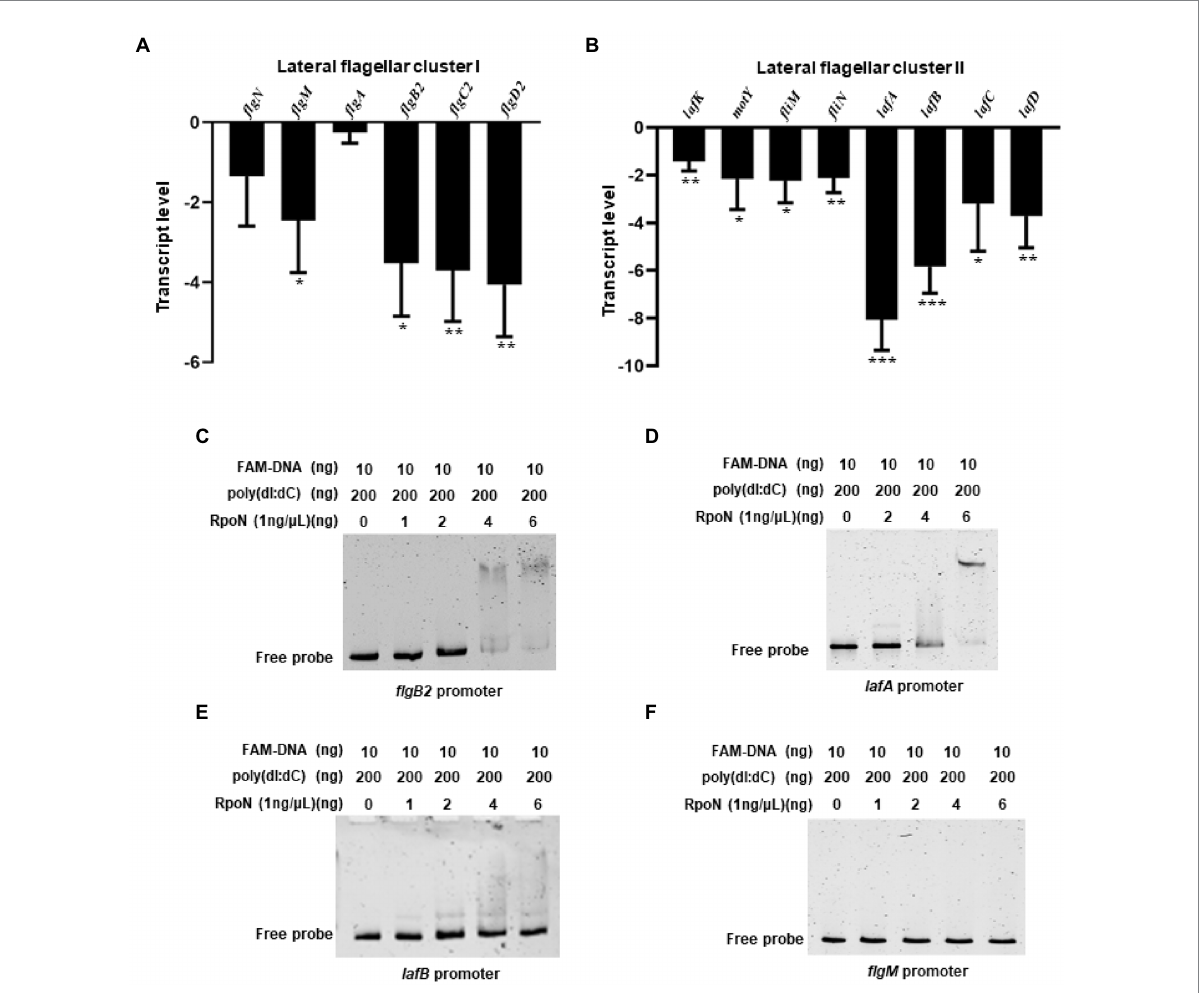
FIGURE 4 RpoN directly binds to the promoters of flgB2 and lafA to regulate the expression of lateral flagellar genes in V. parahaemolyticus . (A,B) qRT-PCR analysis of the transcription levels of lateral flagellar cluster I (A) and lateral flagellar cluster II (B) genes in Δ rpoN compared to WT. The data are presented as the mean ± SD ( n = 3). * p < 0.05, ** p < 0.01, *** p < 0.001, Student’s t test analyzes Δ rpoN compared to WT. (C–F) EMSA analysis the specifically binds of RpoN to the promoters of flgB2 (C) , lafA (D) , lafB (E) , and flgM (F)